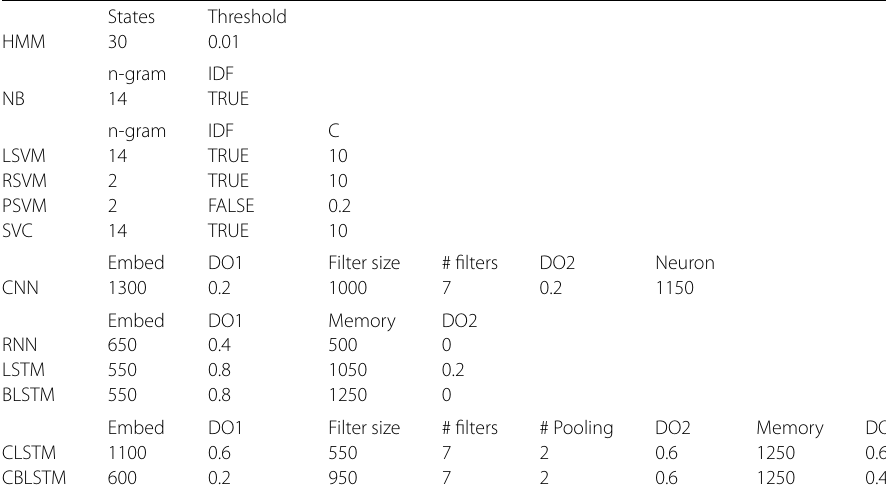
Table 5 The best parameters for the tested models. “States” and “Threshold” are the hidden state number and convergence threshold of the EM algorithm of the HMM. “n-gram” is the gram size in the preprocessing for the NB and SVM models, “IDF” is if to include inverse document frequency (see Sect. 4.2.2) in the preprocessing for the NB and SVM models, and “C” is the penalty parameter of the error term for the SVM models. “Embed” is the hidden node number in the embedded layer (see Sect. 4.1), “DO i ” is the i th fraction of the input units to drop in the dropout layer, “Filter size” is the size of the filter in the convolution layer, “# filters” is the number of filters in the convolution layer, “# Pooling” is the number of neurons to pool in the pooling layer, “Neuron” is the hidden node number in the CNN model, and “Memory” is the memory unit number of the LSTM States Threshold HMM 30 0.01 n-gram IDF